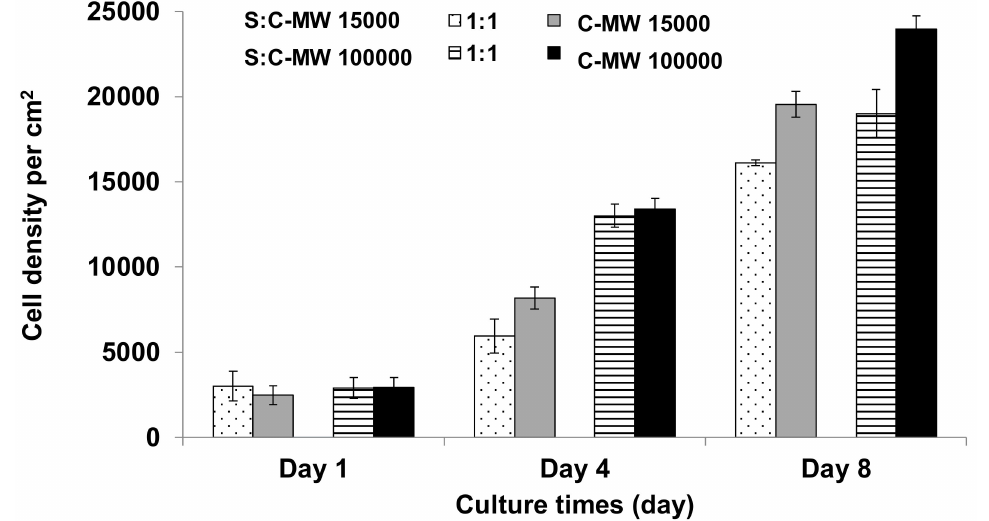
Figure 8. Increase cell density in the media incubated with sericin-chitosan sca ff old with chitosan MW of 15,000 g / mol and 100,000 g / mol at a ratio of 1:1 as compared with pure